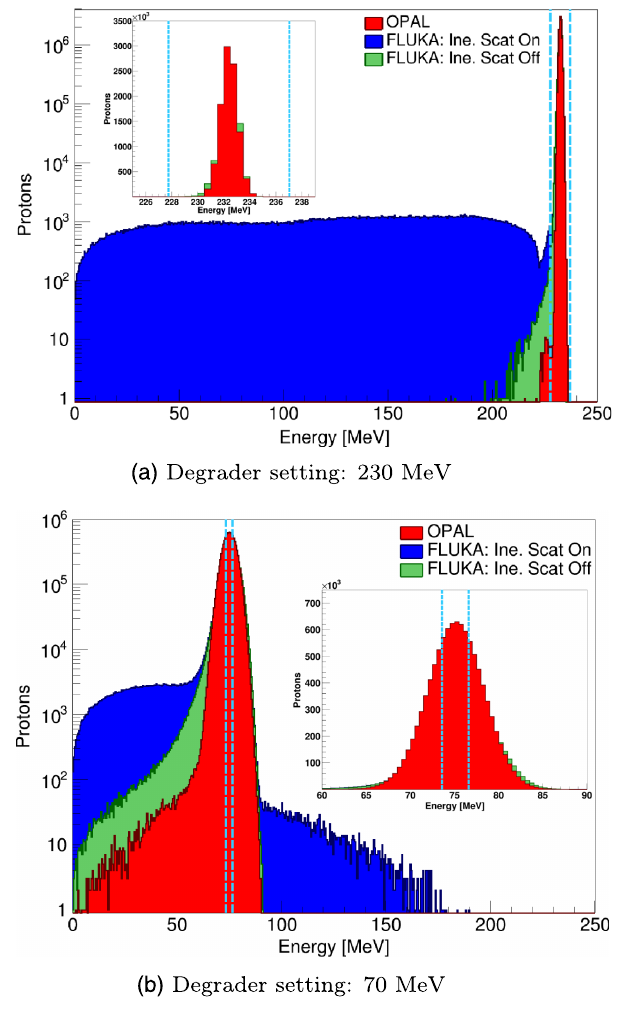
FIG. 7. Energy distribution of the proton beam after the interaction with the degrader. The OPAL results are compared with FLUKA with and without the inelastic scattering contribution. The light-blue dashed lines reproduce the energy acceptance width of the ESS. In the zoom the overlap between the energy peak and the acceptance of the ESS is shown in more detail.